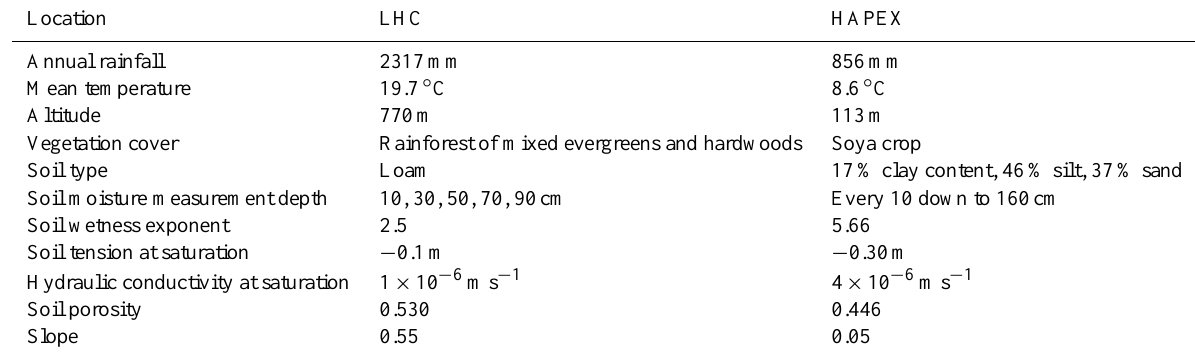
Table 1. Basic parameters used for describing the LHC and HAPEX sites. LHC data were obtained from Wu (2011); HAPEX data were obtained from Goutorbe et al. (1989).